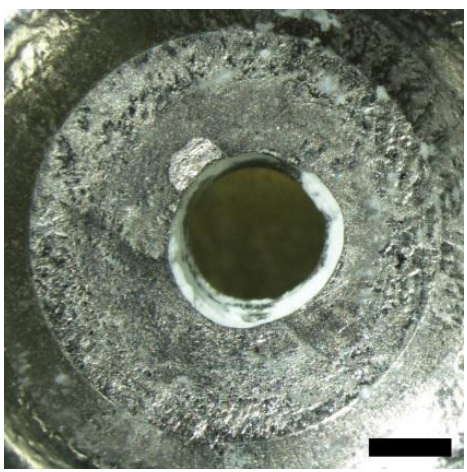
Figure 8. The recovered f-TiZr gasket, which experienced extensive deformation in the high-pressure cell. It was used to compress a powdered Mg(OD) 2 sample to 9 GPa. The scale bar indicates a length of 1